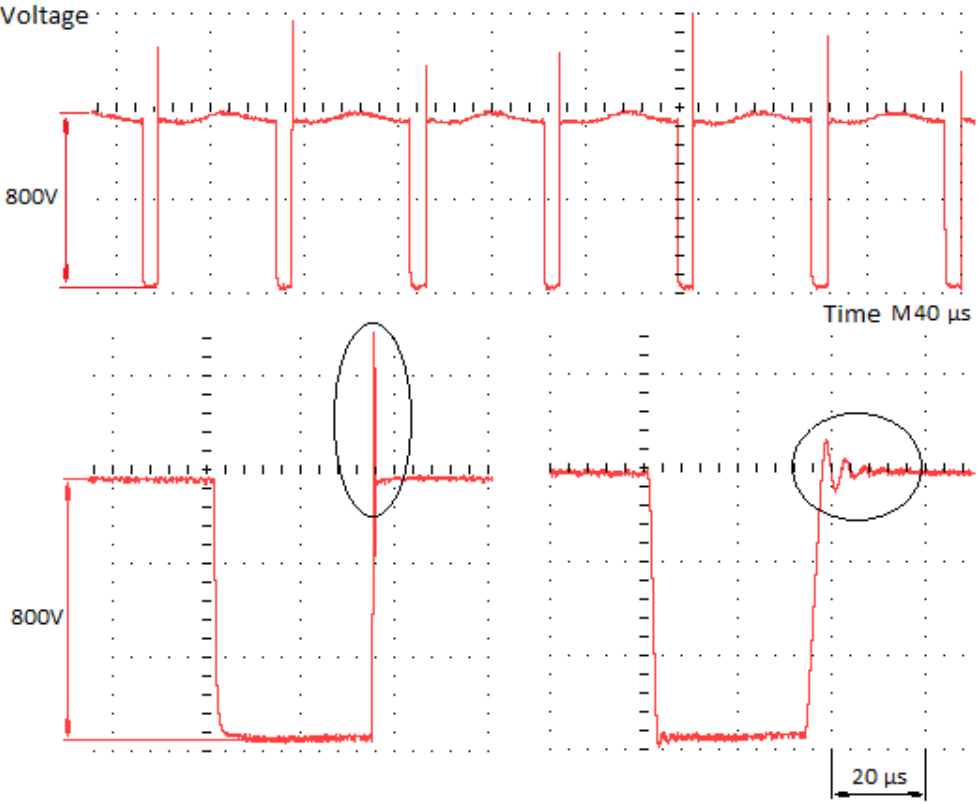
Figure 15. Boost mode of operation. Voltage drain-to-source, boost transistors Q2, module M2.